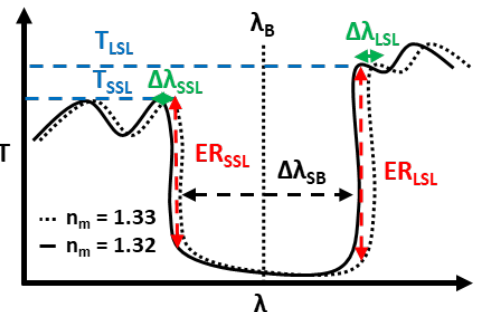
Figure 1. Schematic of transmission spectra for typical uniform MS-SW BG as a sensor.